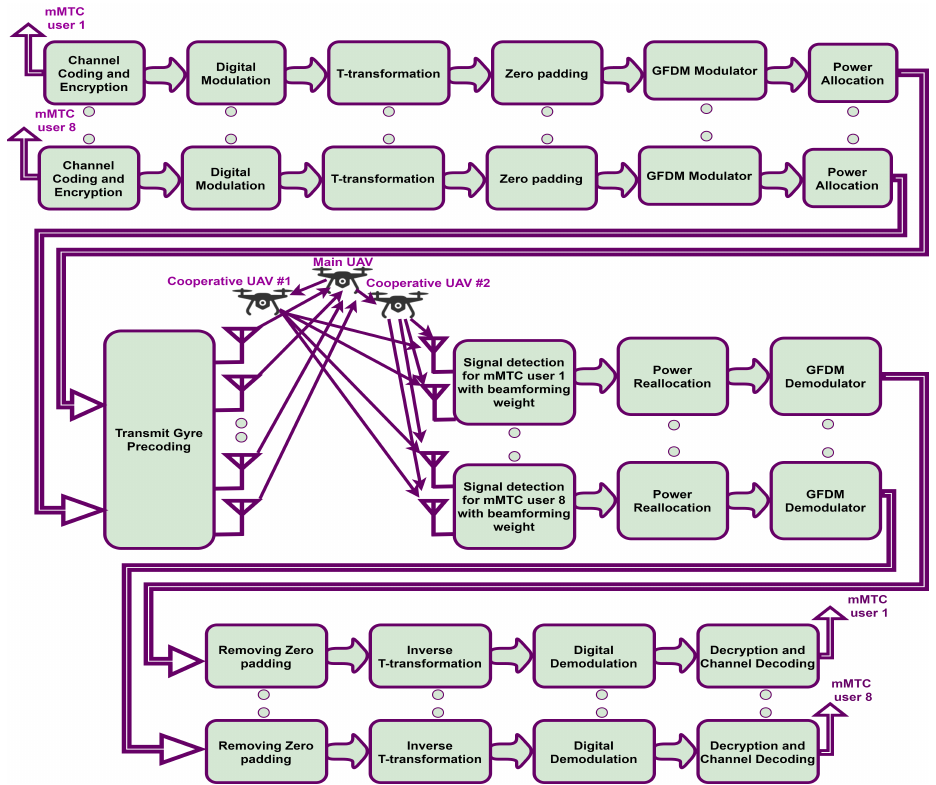
Figure 2. Simplified block diagram of secured cooperative UAV-aided CP-less GFDM system. Initially, complex symbols are produced via the digital modulation of the encrypted binary data [24]. After that, the generated complex symbols undergo T-transformation with a combined effect of the WHT and DFT [25] and zero padded prior to the